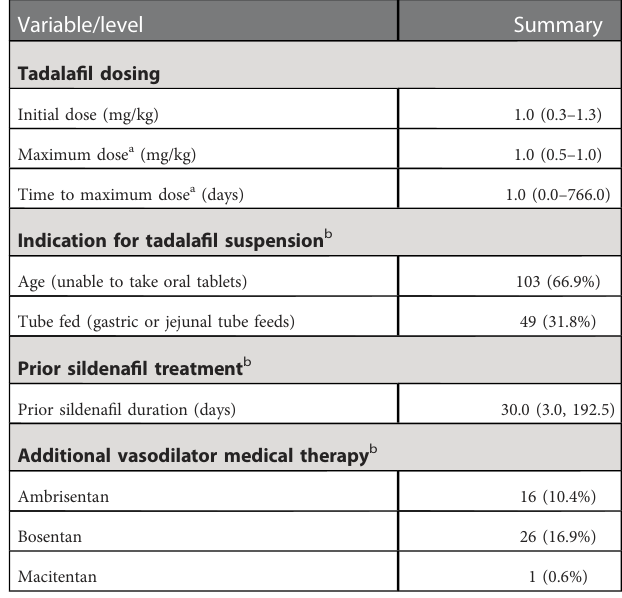
TABLE 2 Patient medication, summarized as median (minimum – maximum), median (Q 1 , Q 3 ), or count (%).